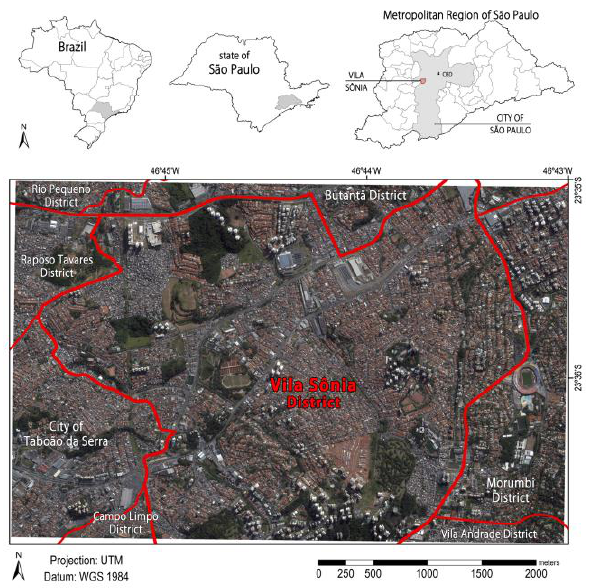
Figure 2. Study area location. WorldView-2 image composition R(5) G(3)